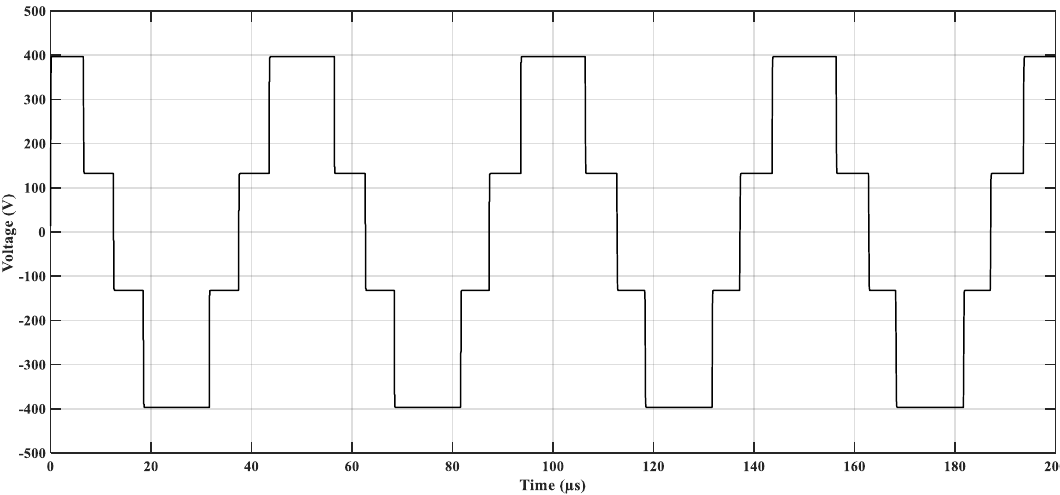
Figure 11. DFIG bearing voltage without the ACMVC.